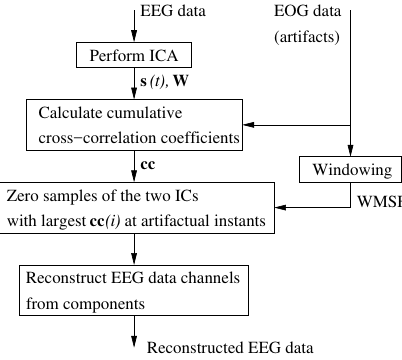
Figure 8. Scheme of the partial removal (PR)